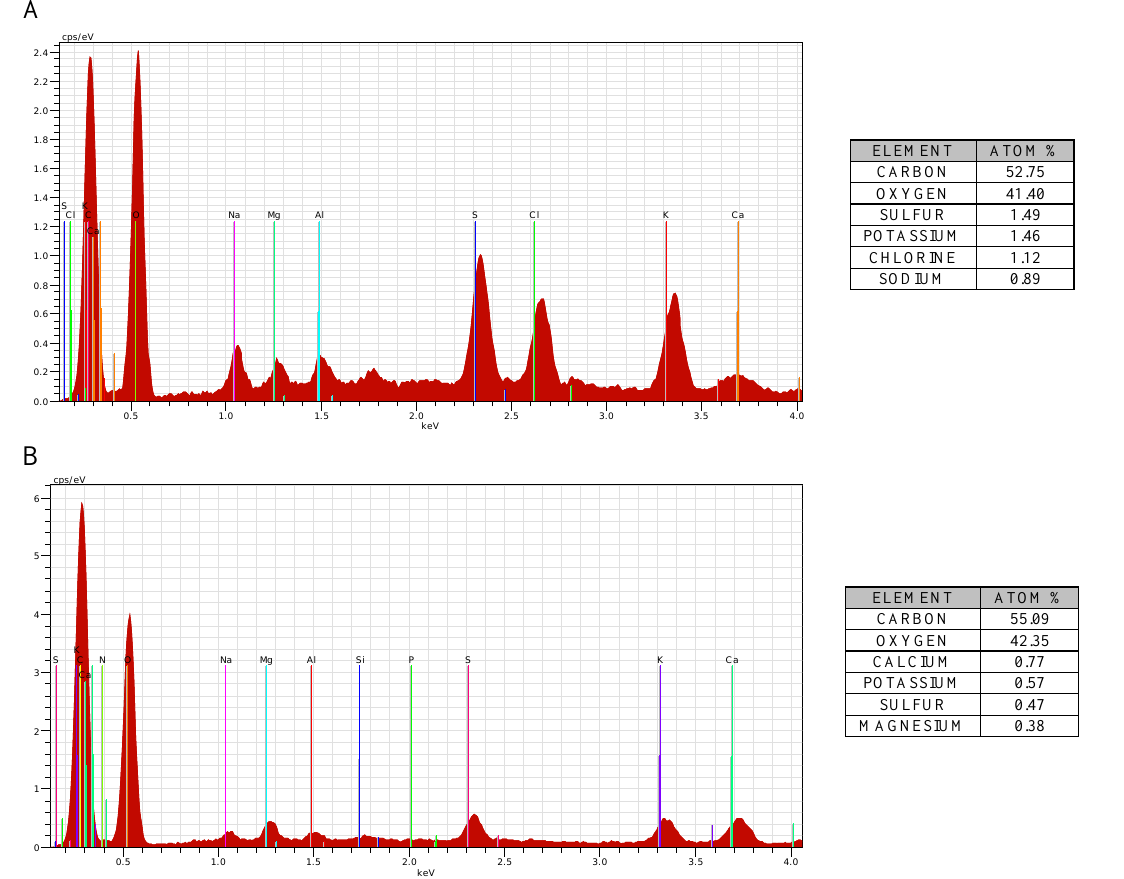
Figure 3. Energy Dispersive X-ray spectra and Atom Percent Abundance of the most prevalent elements for both adsorbents Chaetomorpha ( A ) and Sargassum sp. ( B ). Other elements that are labeled on the spectra, have %ATOM smaller than 0.89% and 0.38% for Chaetomorpha and Sargassum sp. , respectively.